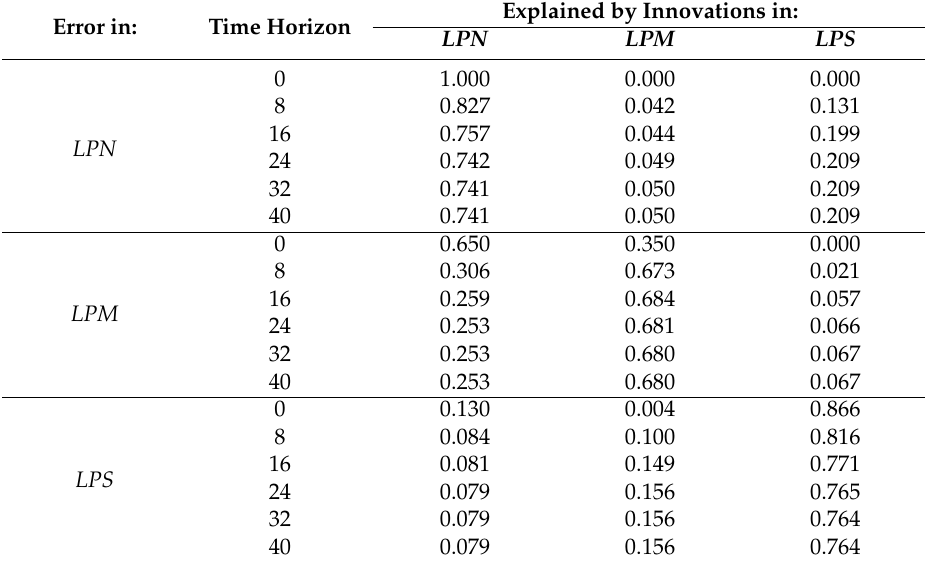
Table 10. Orthogonalized forecast error variance